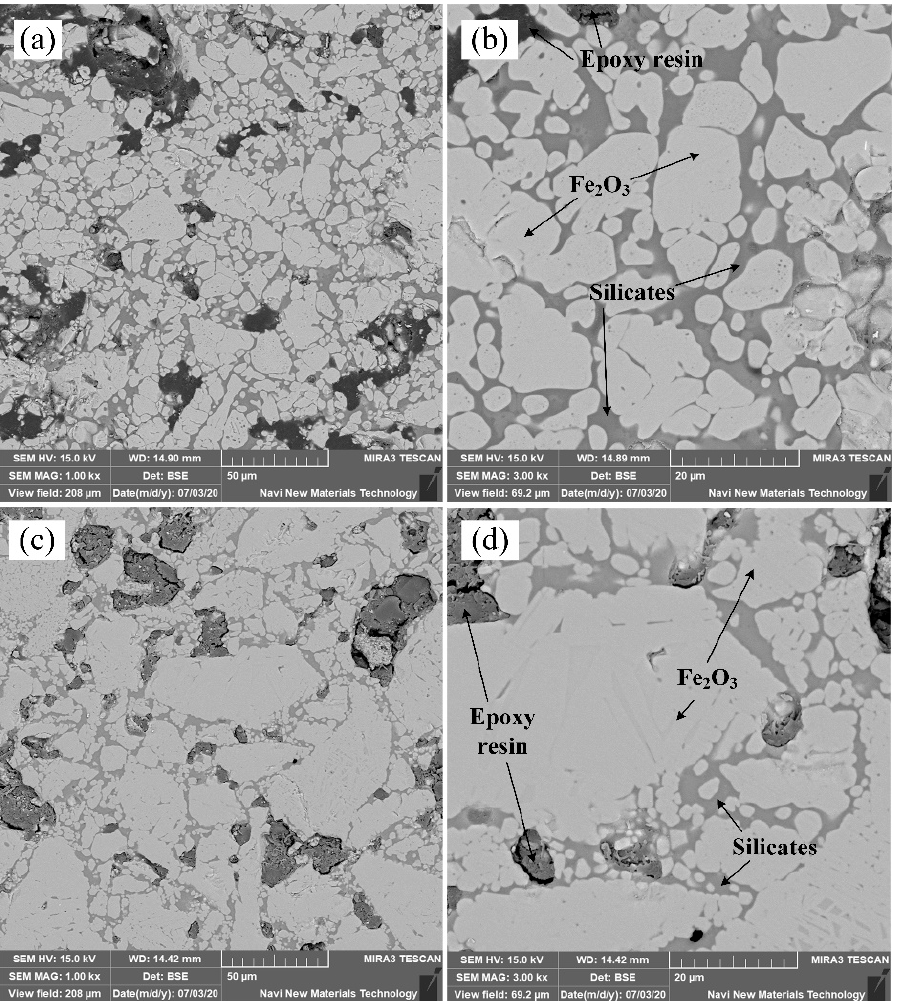
Figure 8. Microstructure of roasted fluorine-bearing iron concentrate pellet without ( a , b ) and with specularite ( c , d ) (preheating at 920 °C for 16 min and roasting at 1080 °C for 10 min).